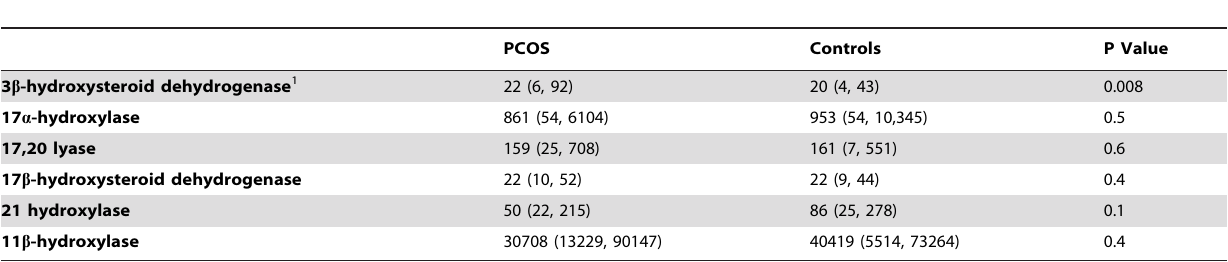
Table 2. Percent product-to-precursor concentrations for adrenal and ovarian enzymes in women with PCOS and controls. Data are expressed as % (2.5, 97.5%